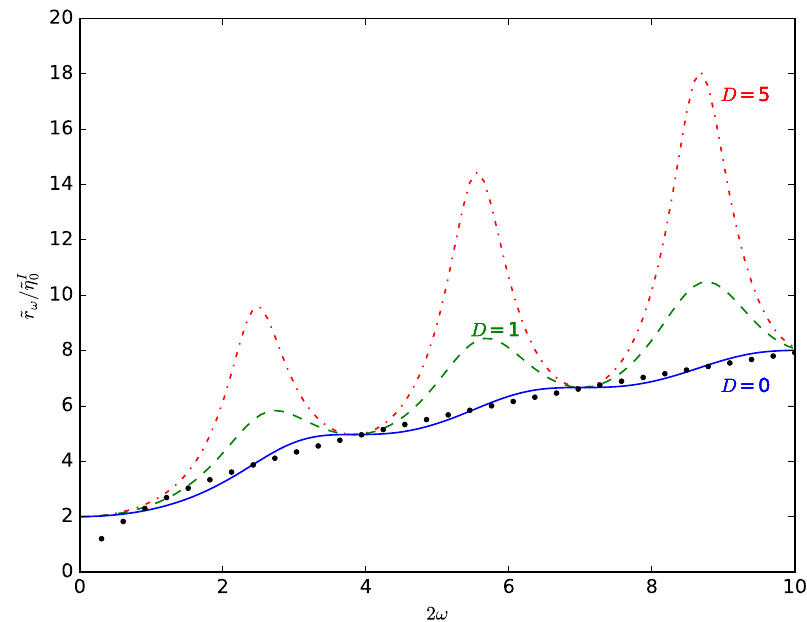
Figure 2. The limiting amplitude of run-up, e r ω , normalised to the amplitude of the incident wave is shown as a function of the frequency of the incident wave multiplied by 2 for Model-1. The depth discontinuity D is 0 for the blue continuous curve, 1 for the green dashed curve and 5 for the red dotted–dashed curve. The black bullets correspond to the limiting run-up given in the expression Eq. (37), normalized to I , for the infinite slope. Here, σ 0 is taken to be one. e η 0